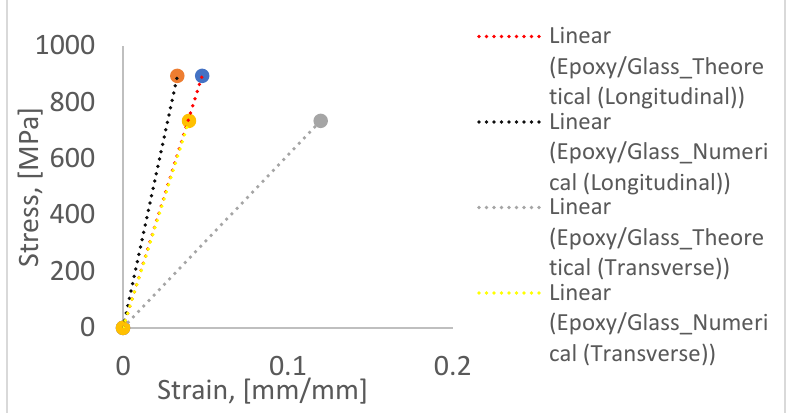
Table 5. Fibre and matrix mechanical properties.